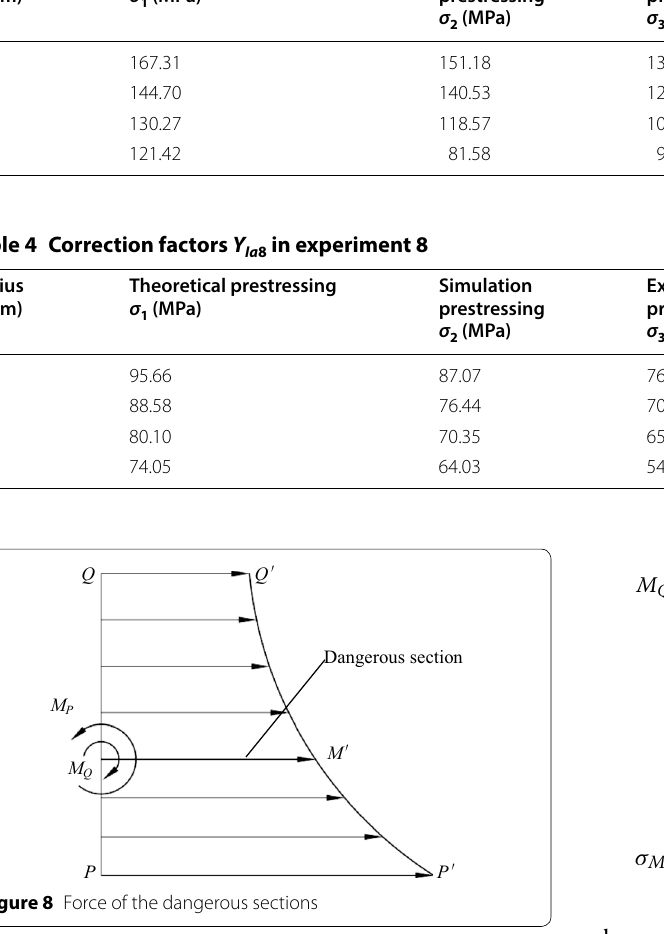
Table 3 Correction factors Y Radius r (mm)